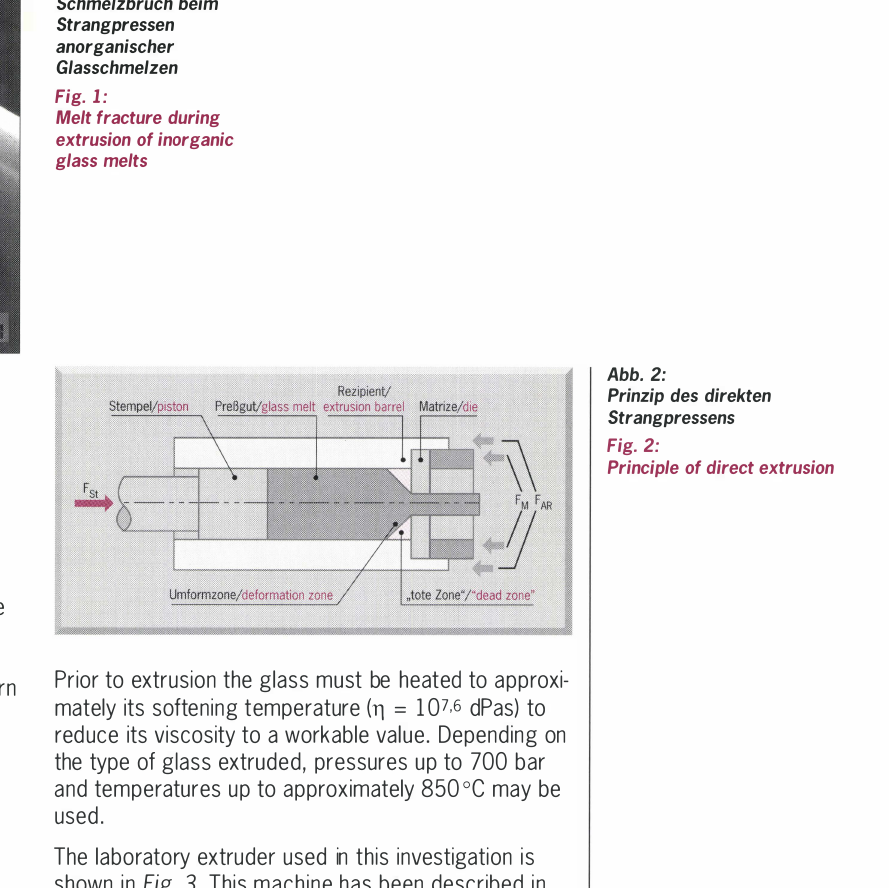
Umformzone/deformation zone